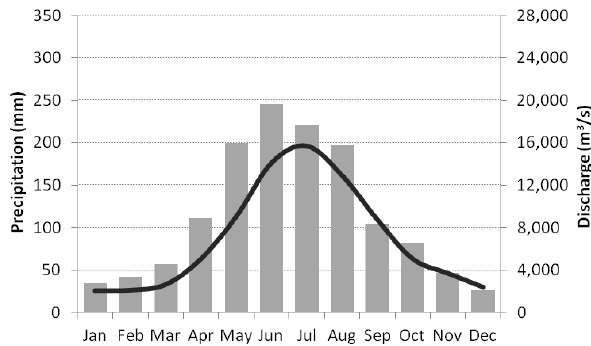
Fig. 3. Average monthly precipitation (grey bars) in the Xijiang River basin and average monthly discharge (black line) at Gaoyao hydrological station 1961–2006.